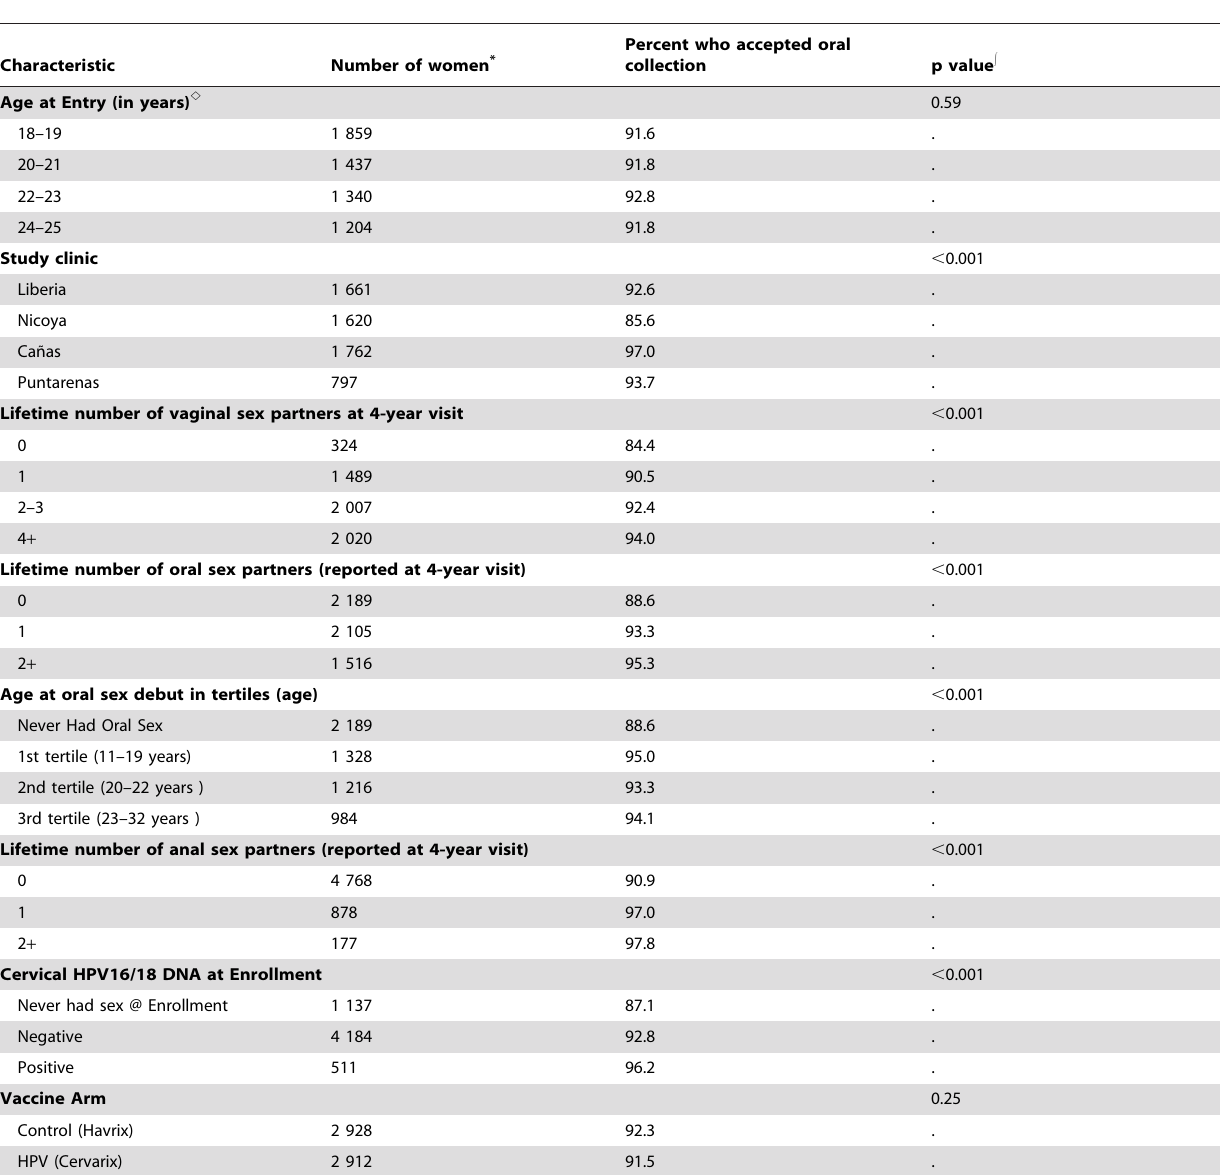
Table 1. Proportion of women who accepted oral specimen collection among all women who attended the 4- year annual visit by selected